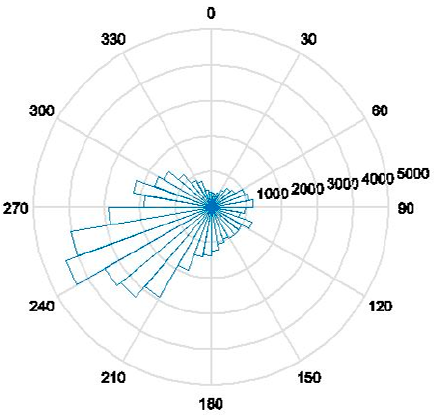
Figure 4. Histogram of wind direction in 2011.